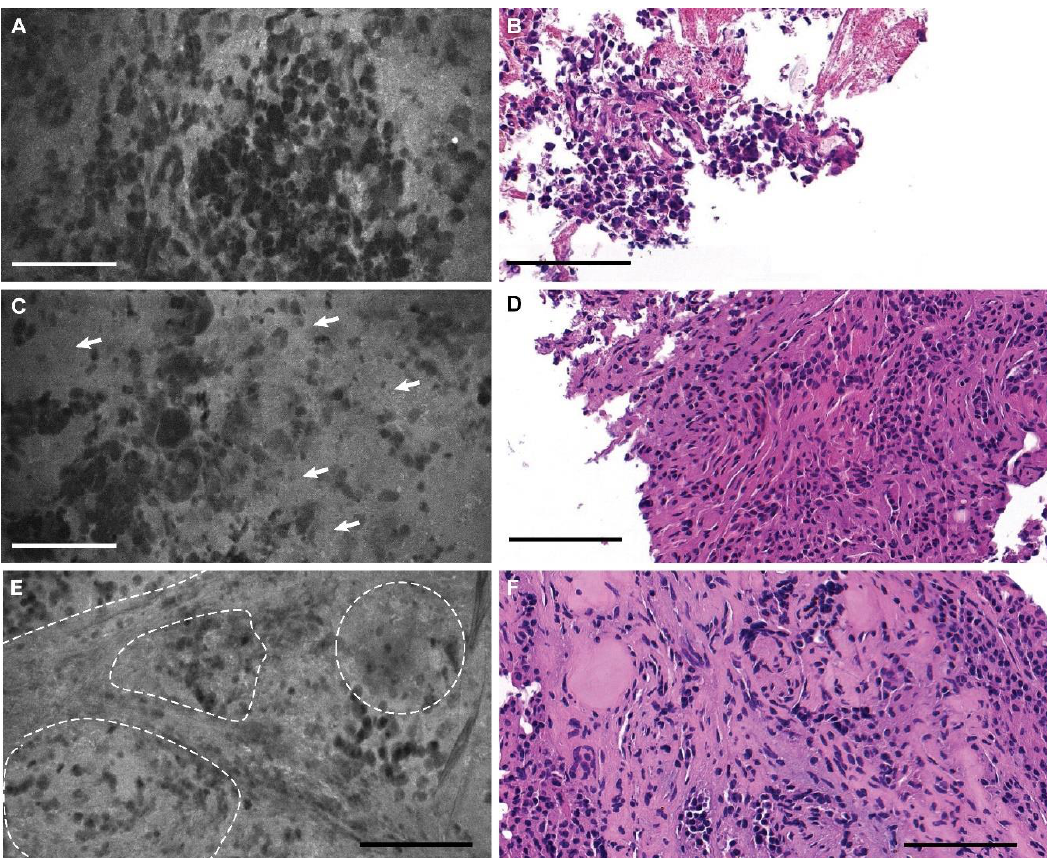
Figure 5. ( A ) Confocal laser endomicroscopy (CLE) image that was nondiagnostic because the biopsy specimen was acquired too early (<1 min after fluorescein injection); ( B ) a hematoxylin and eosin (H&E)-stained section from the same specimen. ( C ) CLE image that was nondiagnostic because the biopsy specimen was acquired too late (>10 min after fluorescein injection), with arrows pointing to the hypercellular areas of tissue with suboptimal contrasting of the cellular outlines; ( D ) an H&E-stained section from the same specimen. ( E ) CLE image showing more uniform lobules of pituitary epithelial cells, suggestive of normal pituitary tissue, with dotted lines outlining lobules; ( F ) H&E-stained section from the same specimen. Bars = 100 μm. Used with permission from Barrow Neurological Institute, Phoenix, Arizona.